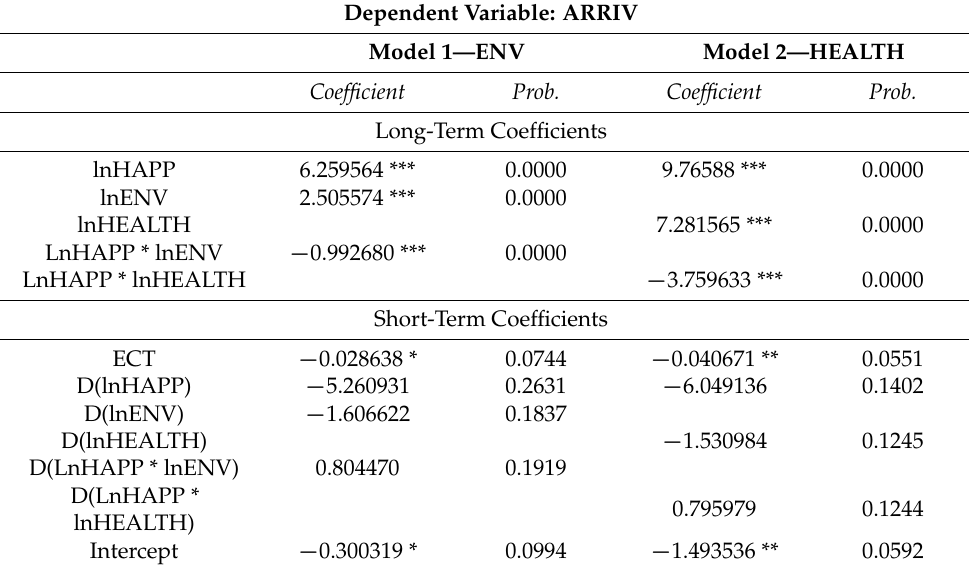
Table 6. ARDL panel estimation. ARRIV—endogenous